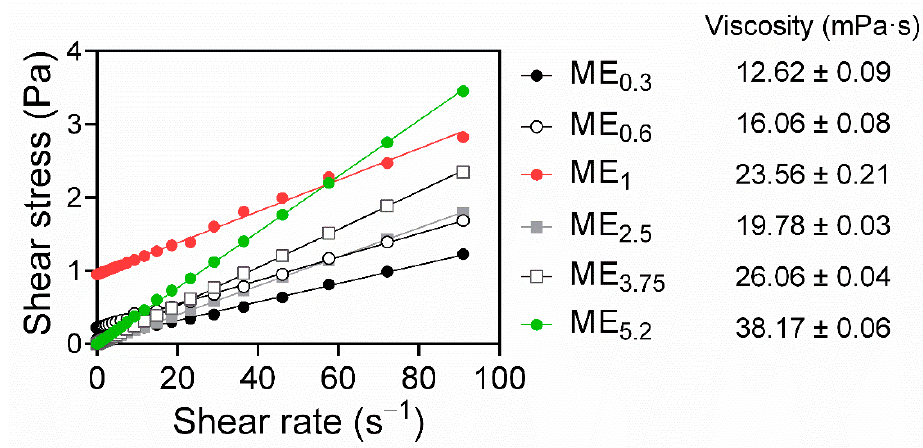
Figure 3. Rheograms of selected MEs, obtained by plotting shear stress versus the shear rate, show Newtonian behaviour for ME 0.3 , ME 2.5 , ME 3.75 , and ME 5.2 , and Bingham behaviour for ME 0.6 and ME 1 (R 2 > 0.99). The ME viscosities are shown as the means ± SD, n = 3.